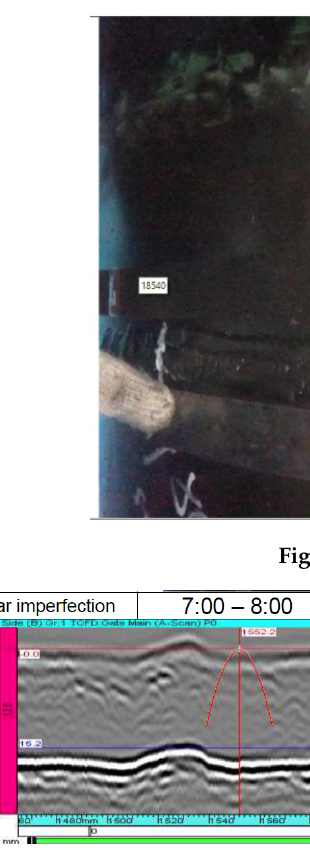
Figure 12. TOFD of GW 18540.